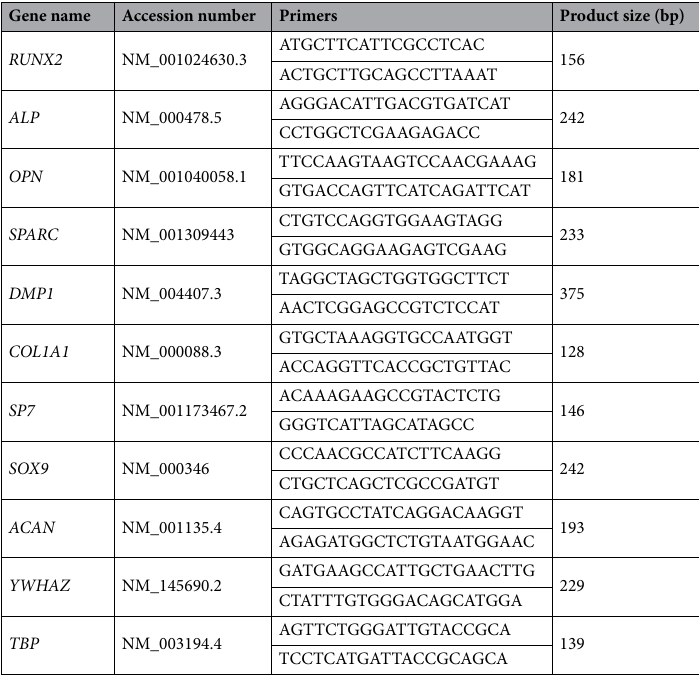
Table 1. Sequence of the primers used for